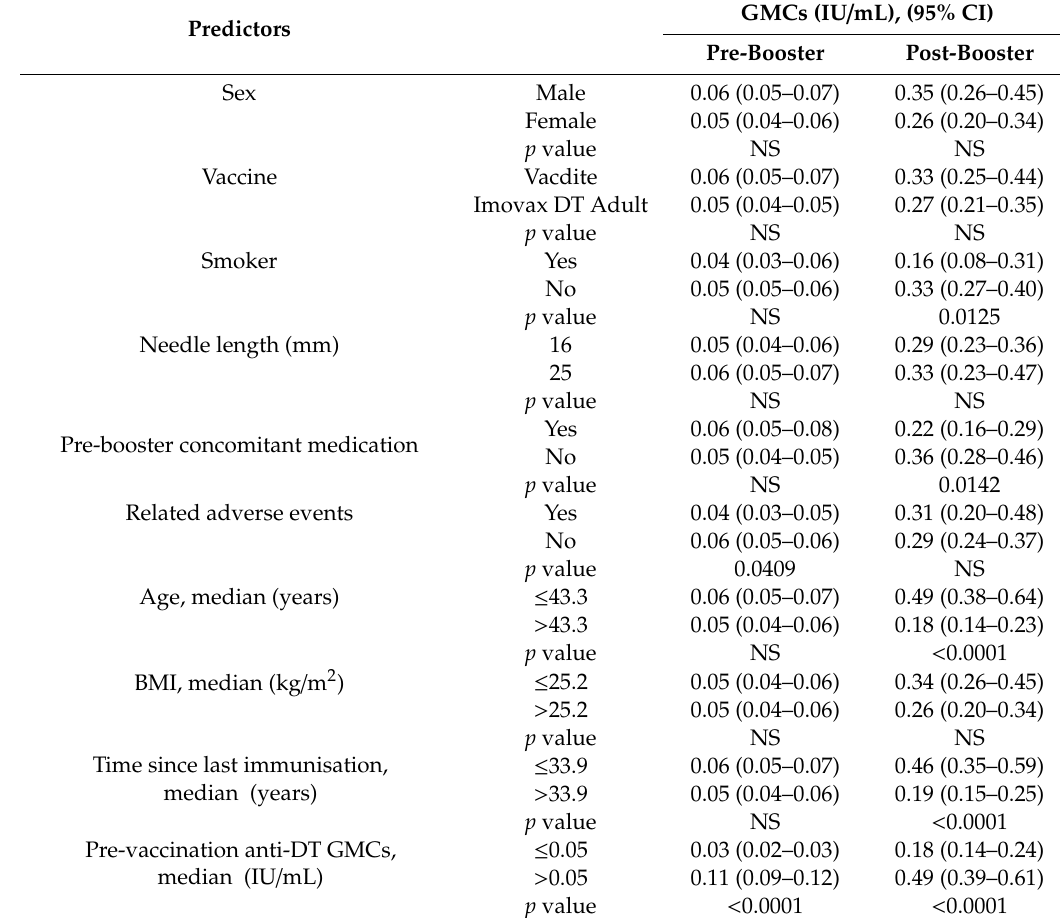
Table 2. Pre- and post-booster geometric mean concentrations (GMCs) of diphtheria antibodies, including the 95% confidence interval and p value between